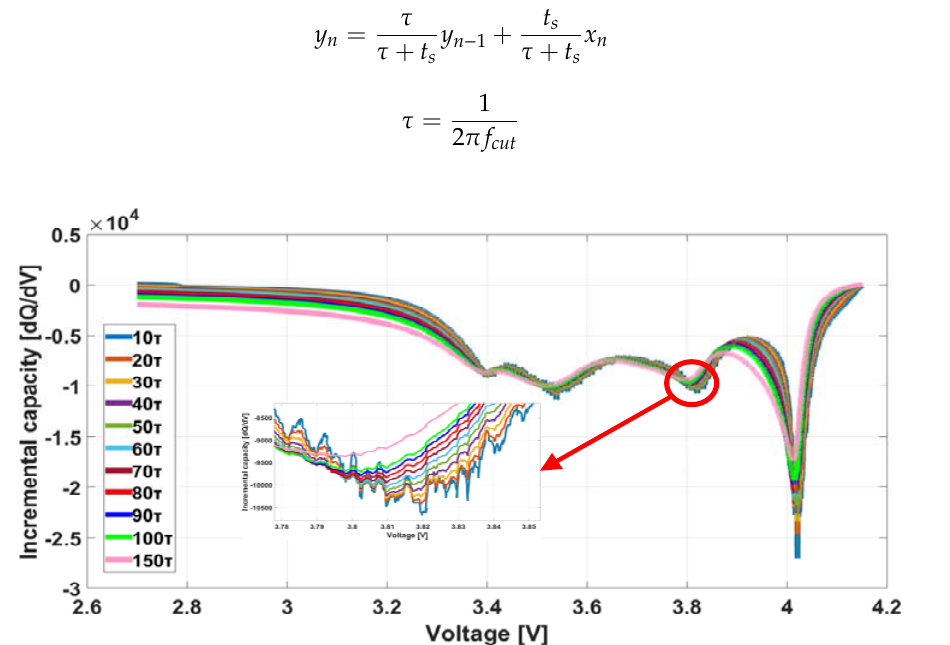
Figure 8. Smoothing of the IC curve using a low ‐ pass filter (LPF).